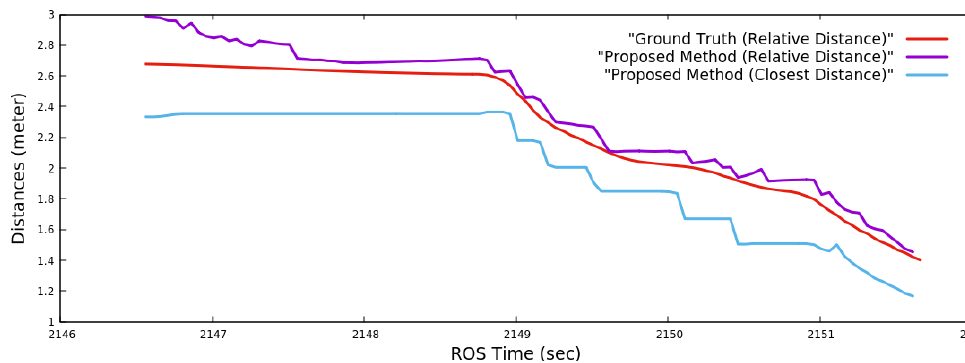
Figure 16. The closest distance estimation of the Husky2 by the proposed method against the ground truth of relative distances of the experiment presented in Section 4.2.3.